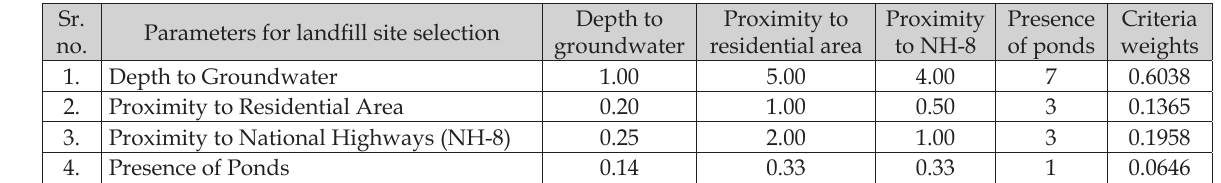
Table 2. Pairwise comparison and relative weights of different parameters.